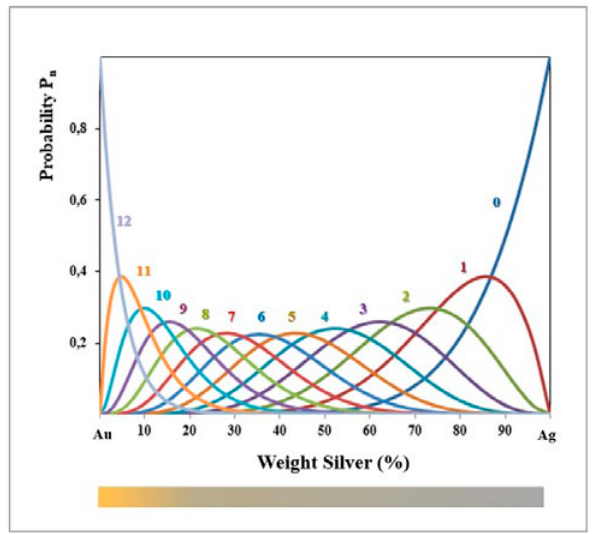
Figure 4. Probability (P n ) for a gold atom to display n homome- tallic contacts against the percentage of weight silver in gold-silver alloys. P n functions are calculated using the same statistic expres- sion used by Martinez at al. [17]. Note: the absence of a mirror plane across 50% of the silver is due to the different weights of the two precious